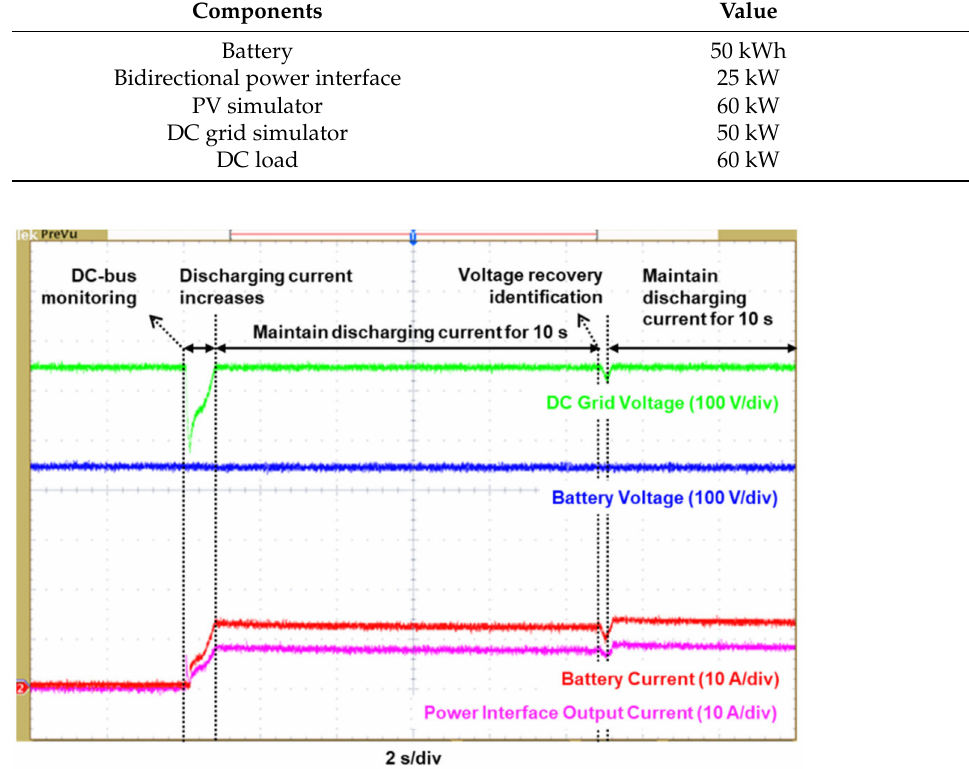
Figure 14. Experimental results of proposed voltage regulation algorithm at undervoltage